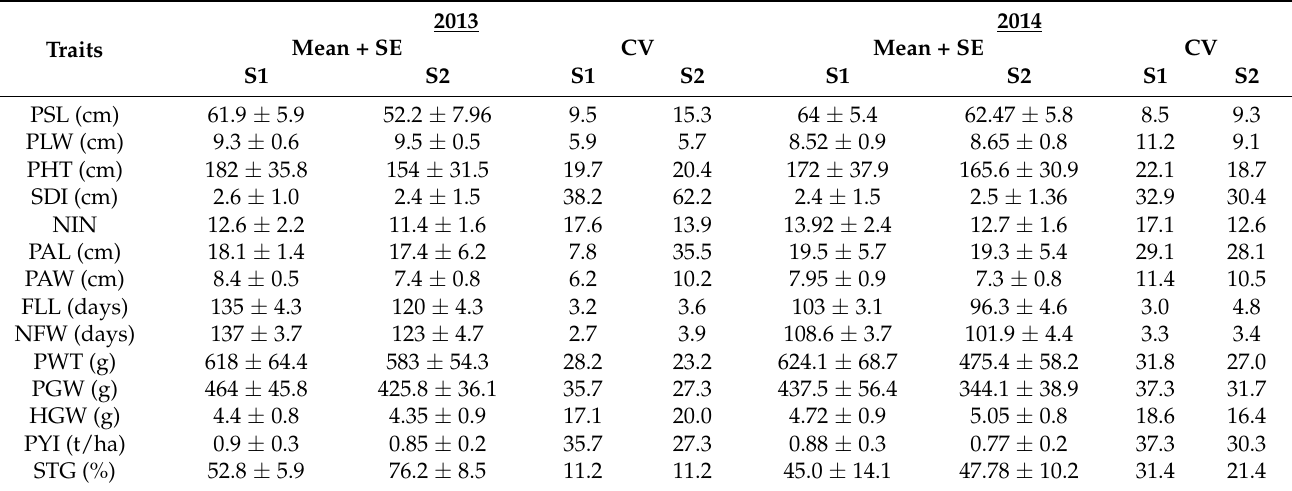
Table 3. Mean values plus/minus standard error (SE) and coefficients of variation for 14 traits assessed on 55 Chadian dry-season sorghum cultivars sown at different sowing dates (S1, early and S2, late) in the 2013 and 2014 growing seasons at the You é research farms in Chad.